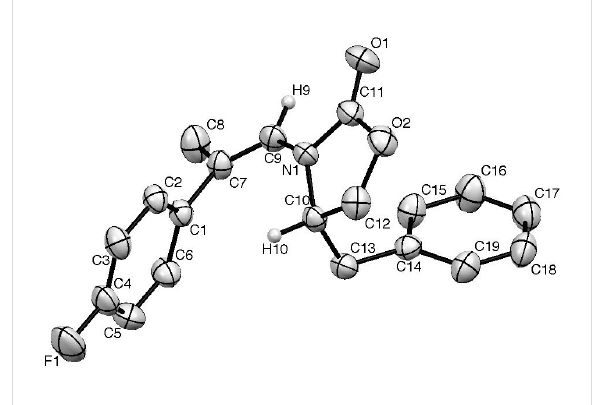
Figure 1: Molecular structure of 9f (hydrogen atoms except of H9 and H10 are omitted for